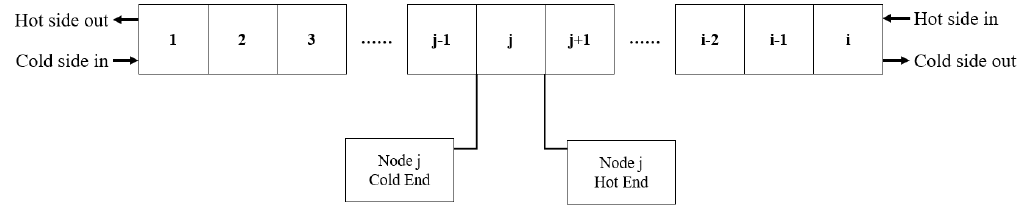
Figure 5. The nodalization of the heat exchanger.